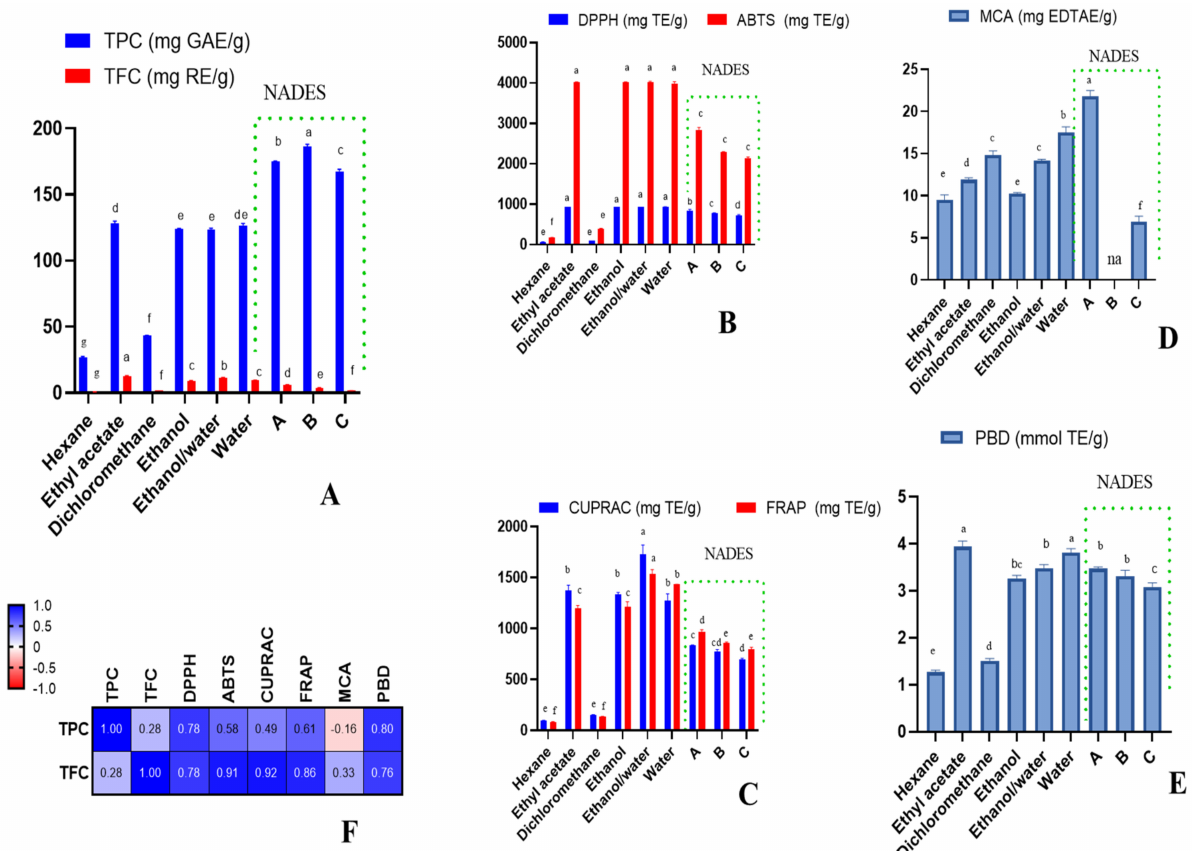
Figure 1. Total phenolic and flavonoid content ( A ), radical scavenging ability ( B ), reducing power ( C ), metal-chelating ability (MCA) ( D ), total antioxidant ability (by phosphomolybdenum assay (PBD)) ( E ), and Pearson’s correlations between total bioactive compounds and antioxidant assays ( p < 0.05) ( F ). na: not active; different letters in column for same assays indicate significant differences in the extracts ( p <